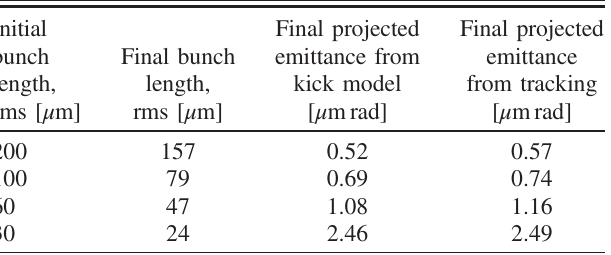
TABLE II. Analytical CSR kick model vs E LEGANT particle tracking prediction of projected emittance growth for the beam line sketched in Fig. 2. The initial bunch has E ¼ 1